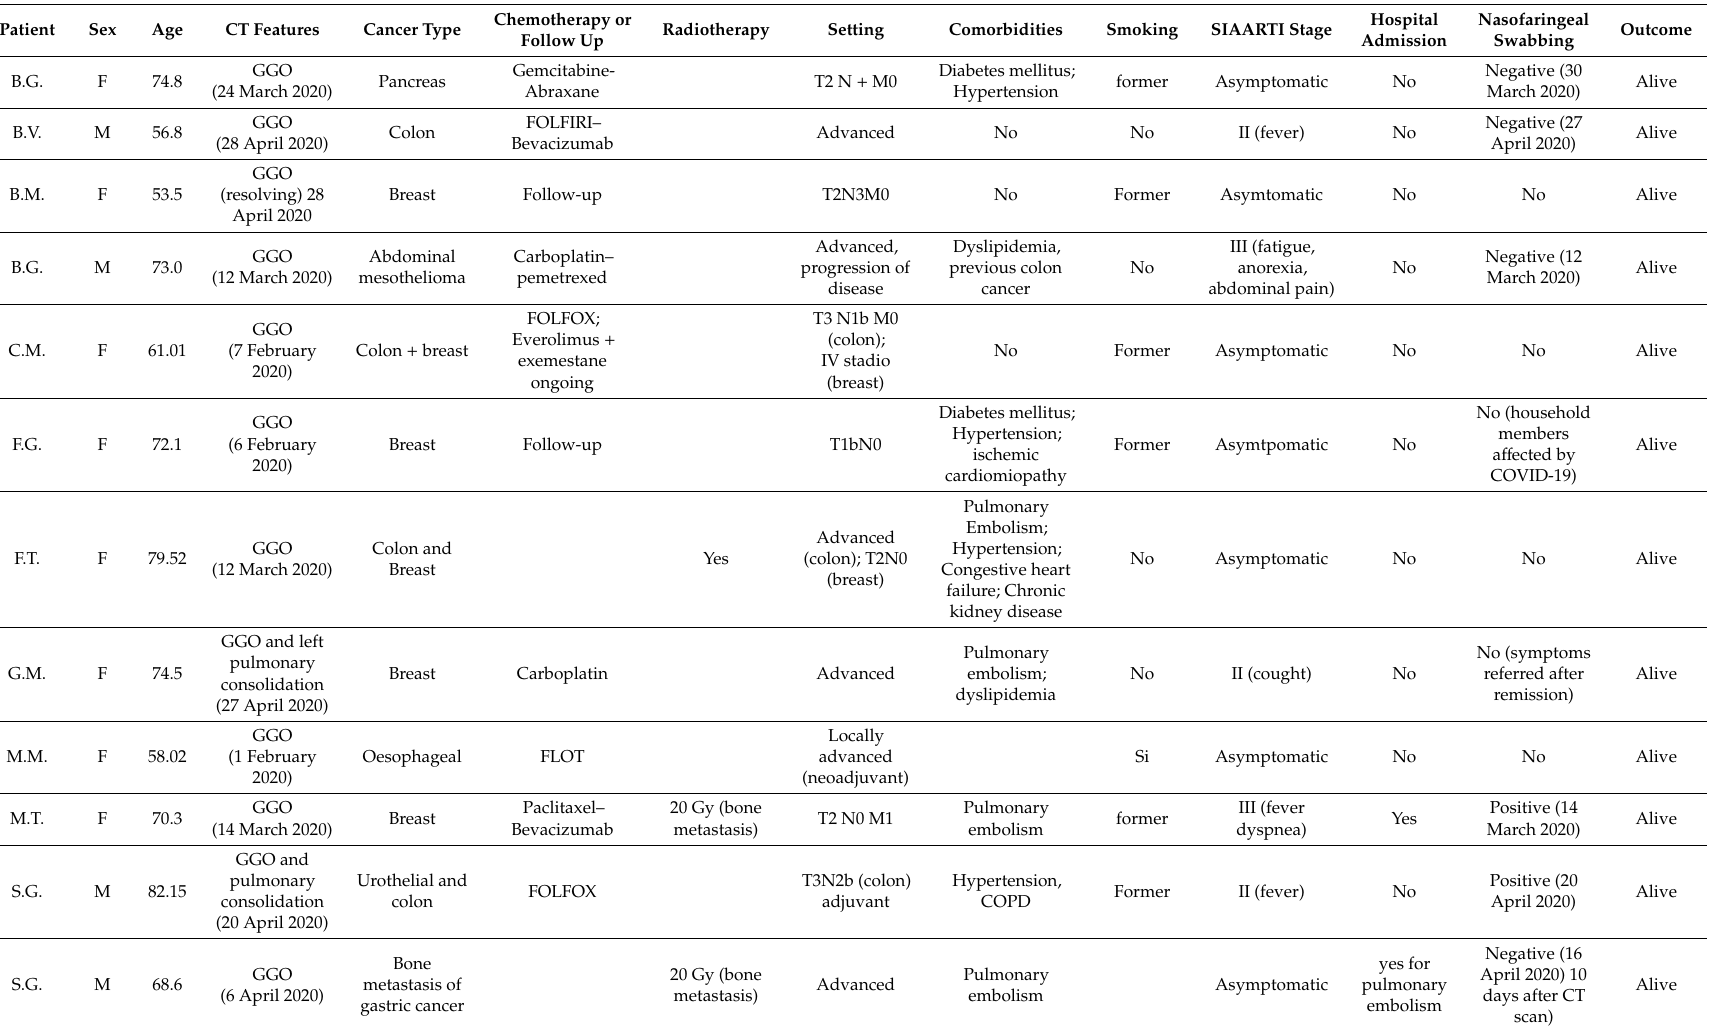
Table 1. Characteristics of cancer patients with coronavirus disease 2019 (COVID-19). GGO, COPD, HBV, HCC, NHL, DLBCL, MCL, R-CHOP / R-DHAP, CLL; HD, ICU. Patient Sex